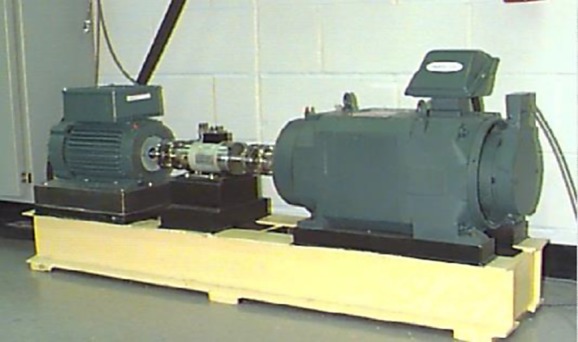
Experimental set-up.